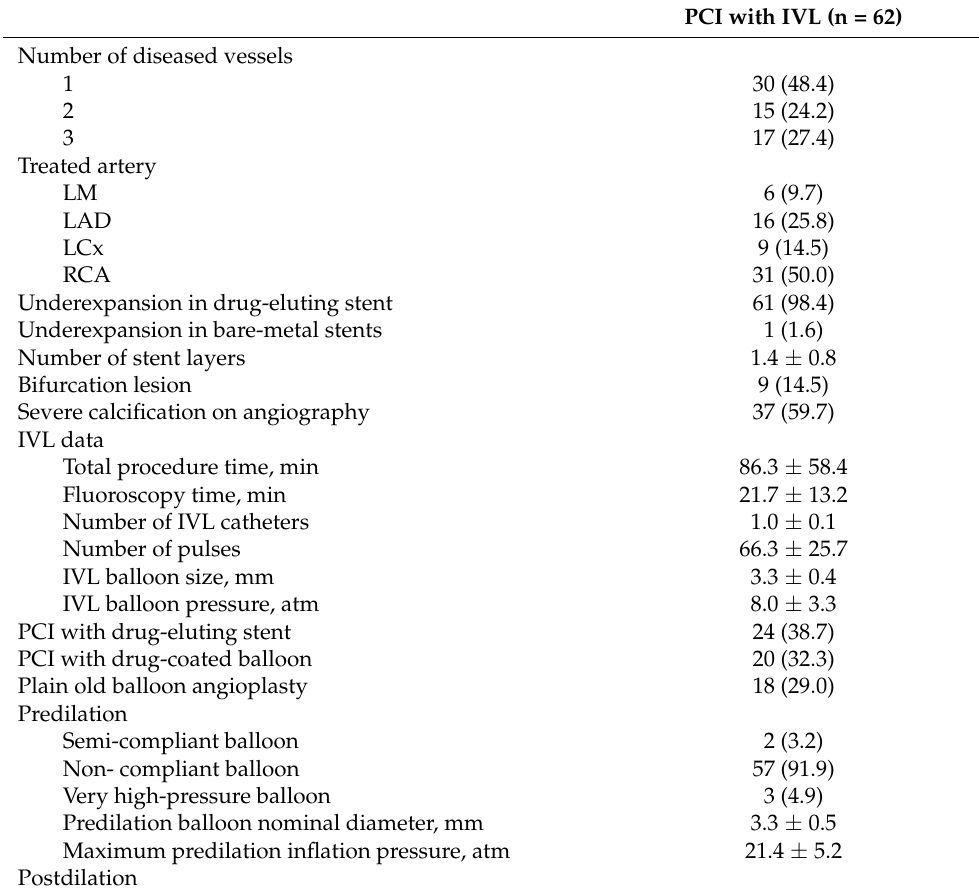
Table 2. Angiographic, procedural, and medication